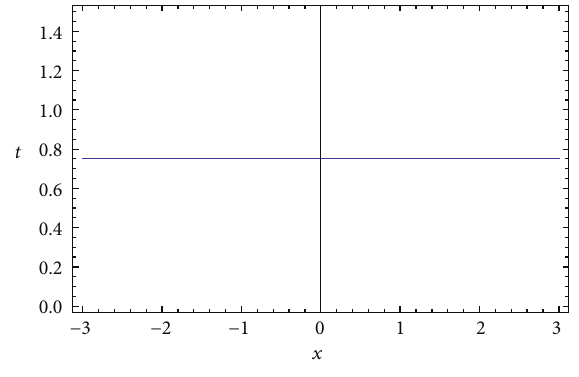
Figure 14: 2D, OHAM solution of 𝜇(𝑥,𝑡) at 𝑡 = 0.1 .